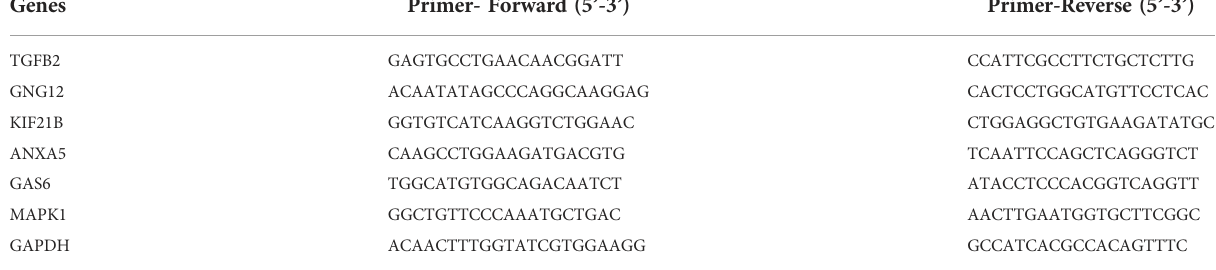
TABLE 1 The Primer pairs utilized in Real-Time PCR.